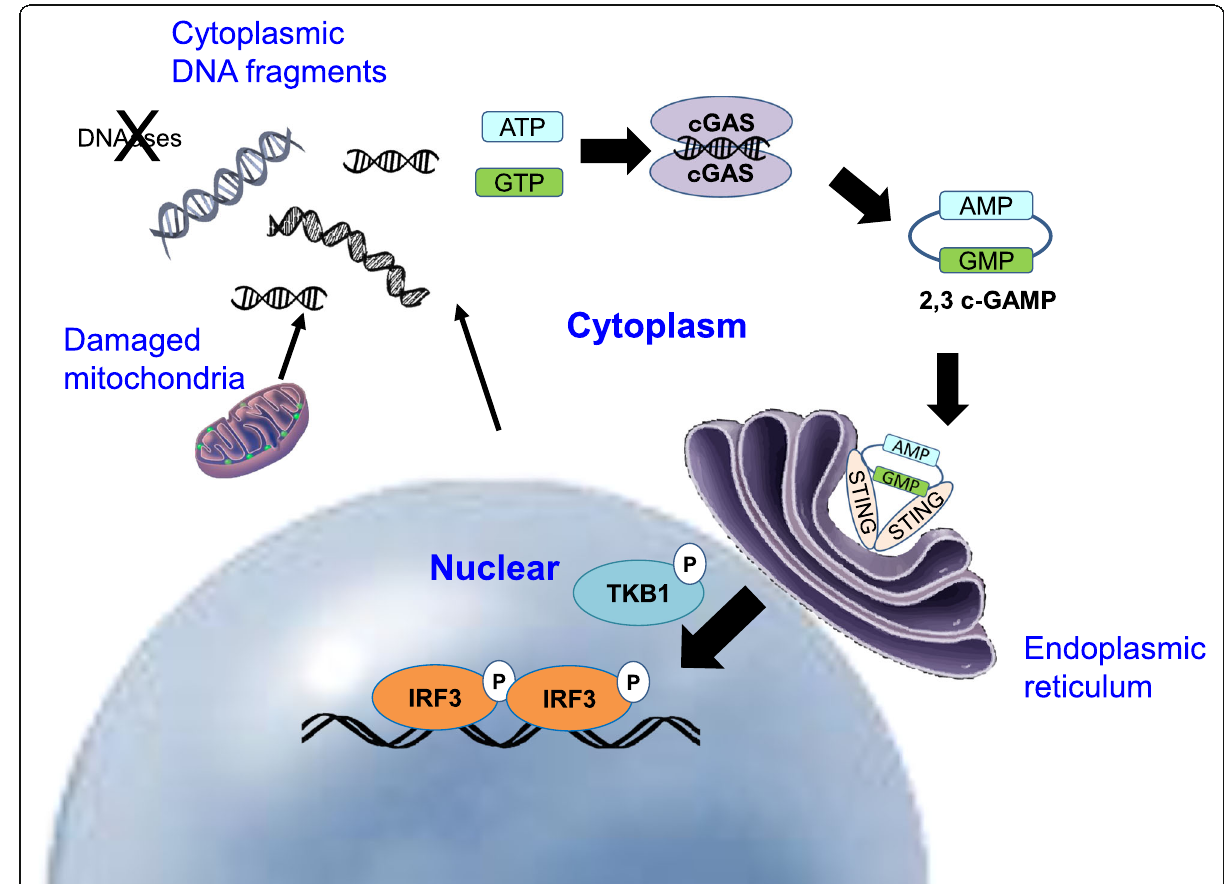
Fig. 2 The intrinsic pathway of SASP induction in senescence: activation of cGAS-STING pathway by abnormal cytoplasmic DNA fragments. Abnormal cytoplasmic DNA fragments produced during cellular senescence act as a ligand of the DNA sensor, cGAS-STING. The cGAS, cyclic GMP-AMP synthase, triggers the reaction to produce cyclic di-nucleotide, cyclic GMP-AMP (cGAMP), that is recognized by STING, thereby facilitating the type 1 interferon- producing pathway activated by phosphorylated IRF3. Normally, DNases such as DNase2 and TREX1 degrade cytoplasmic DNA fragments emanating from the nucleus or damaged mitochondria. In senescent cells, the expression of these DNases is downregulated, resulting in cytoplasmic accumulation of DNA fragments. The remaining DNA fragments aberrantly activate the cytoplasmic DNA sensor,